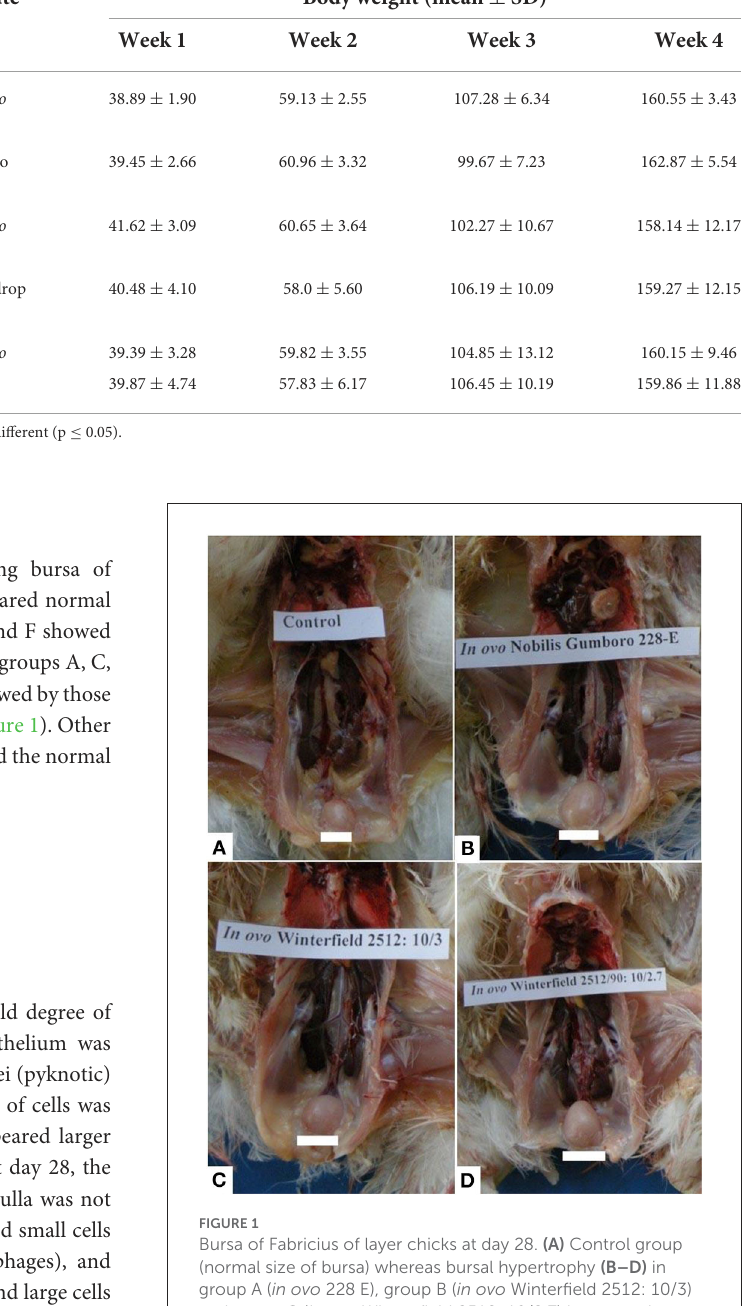
TABLE 3 Body weights (mean ± SD) of the White Leghorn chicks administered live IBD vaccines in ovo and post-hatch period. Groups